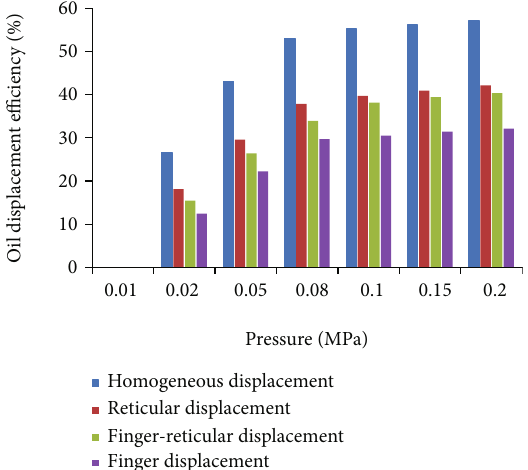
Figure 9: The relationship between displacement e ffi ciency and displacement pressure.